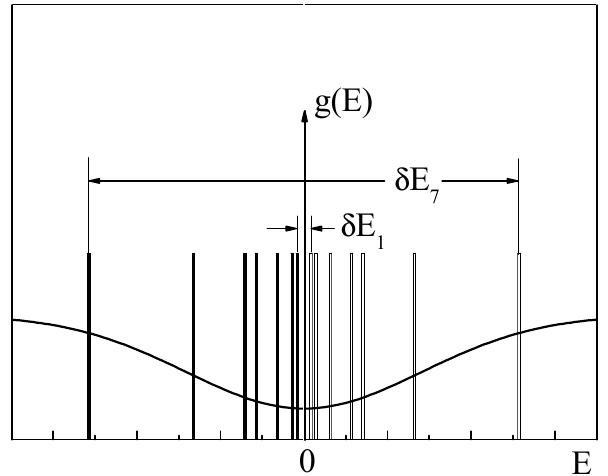
Figure 10. An updated version of the electronic structure model. Shown schematically is the superposition of two types of spectra: the continuum spectrum with a pseudogap and the discrete spectrum with seven types of two-level states. The Fermi level is fixed at the centre of the smallest gap separating the symmetric and antisymmetric states. For the sake of representativity, a nonlinear scale E 1/2 is used. To simplify, only the smallest ( δ E 1 ) and the largest ( δ E 7 ) gaps are indicated by arrows. On the other hand, the supposition that the continual and discrete components in our model are autonomic subsystems is confirmed firmly enough by Ziner’s mechanism of the fine structure of tunnel spectra.